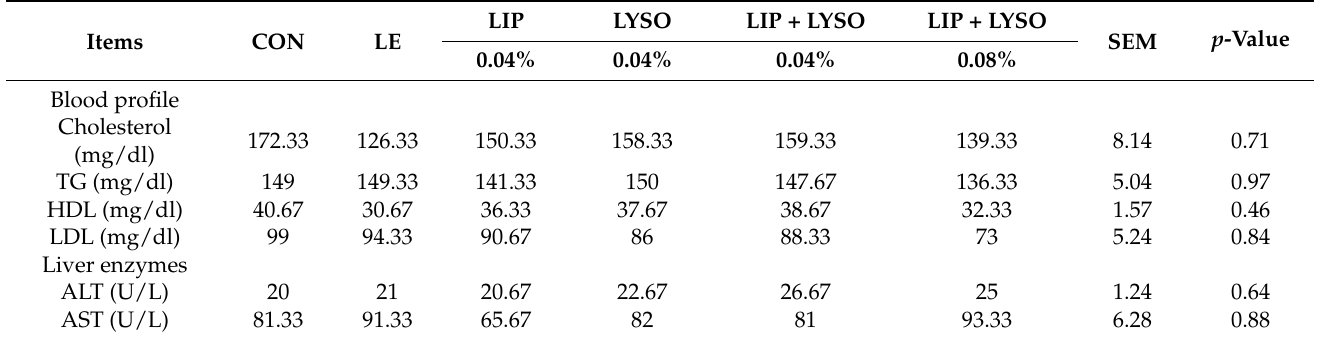
Table 4. Effect of low energy diet and supplementation of emulsifier and lipase on blood biochemical profile of broiler